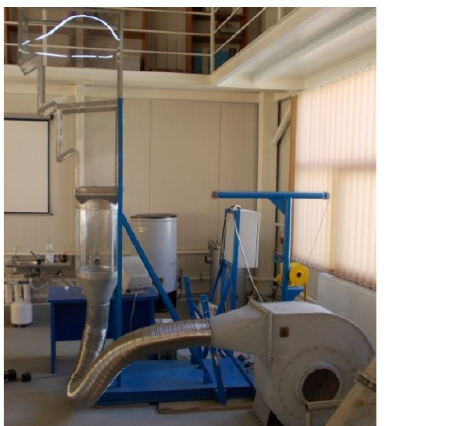
Figure 1. The image shows laboratory equipment and some of the particles that were utilized [19]. Table 1. Presentation of input parameters [19].